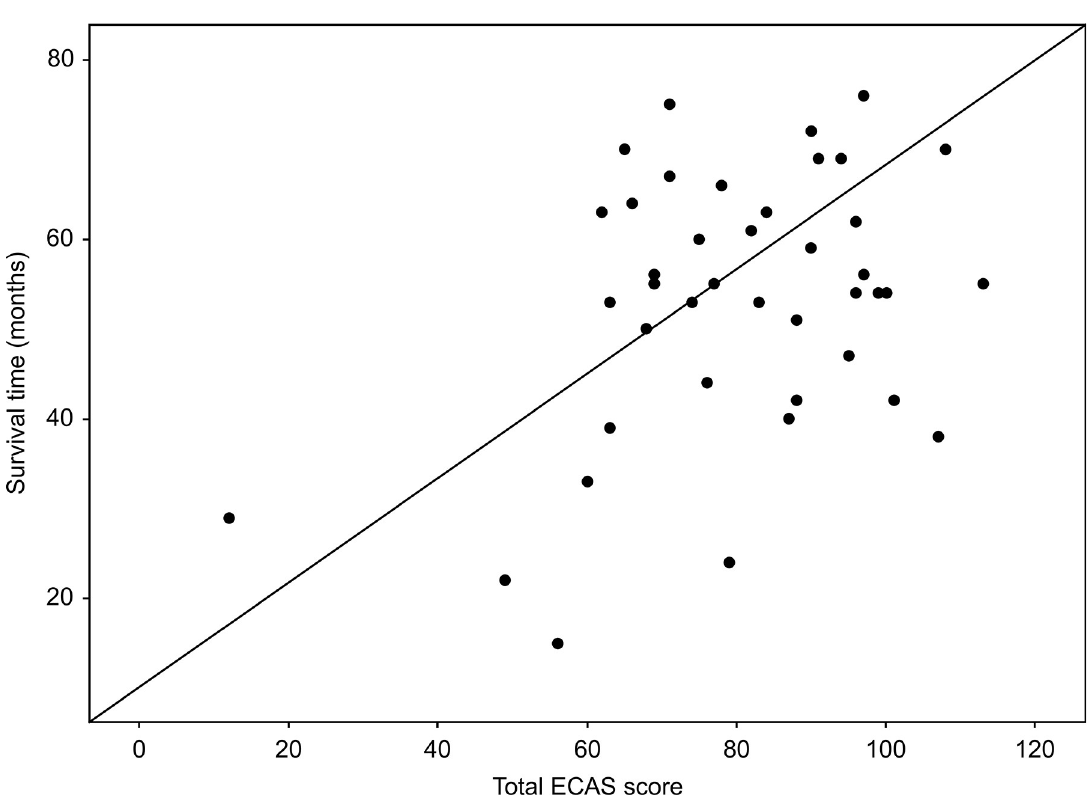
Fig 5. Correlation between total ECAS score and survival